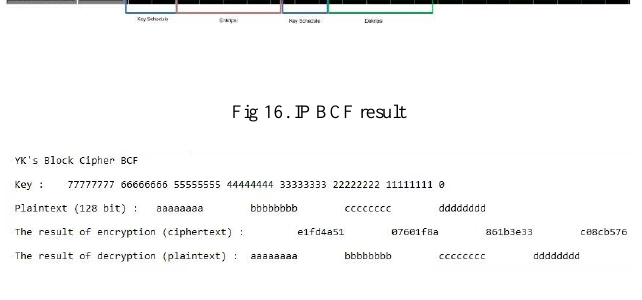
Fig 16. IP BCF result